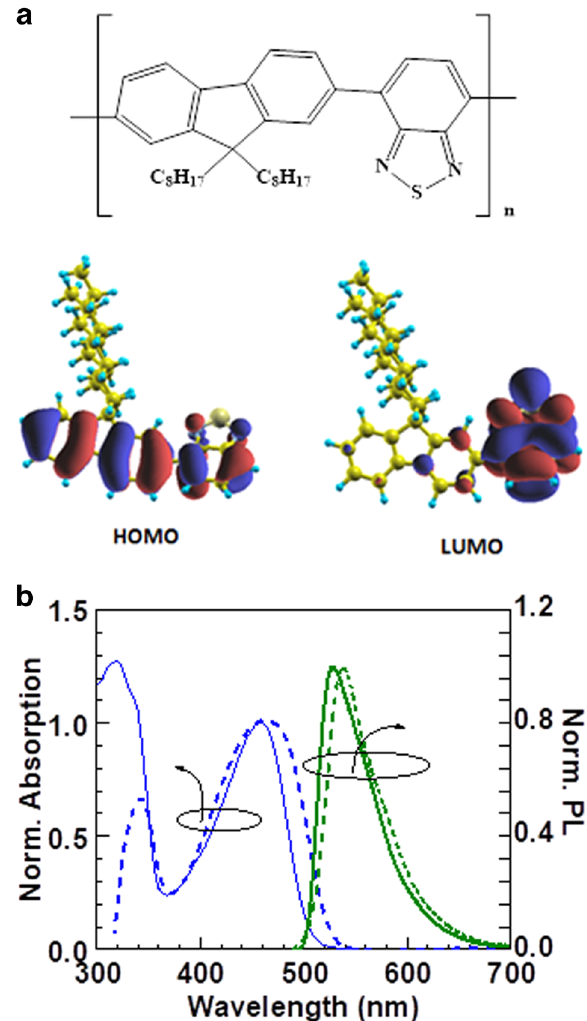
Fig. 1 Chemical structure and steady state characteristics of F8BT. a Typical chemical structure of F8BT co-polymer system and calcu- lated HOMO and LUMO spatial distribution in F8BT, with isosurface value ± 0.02 a.u. at the TD-B3LYP/6-311 + G(d,p) level of theory. b Absorption spectra of F8BT solution (blue solid line) and solid fi lm (blue dashed line). Photoluminescence (PL) spectra of the F8BT solution in p -xylene (green solid line) and in the solid fi lm (green dashed line). The absorption and PL in solid is red-shifted from the